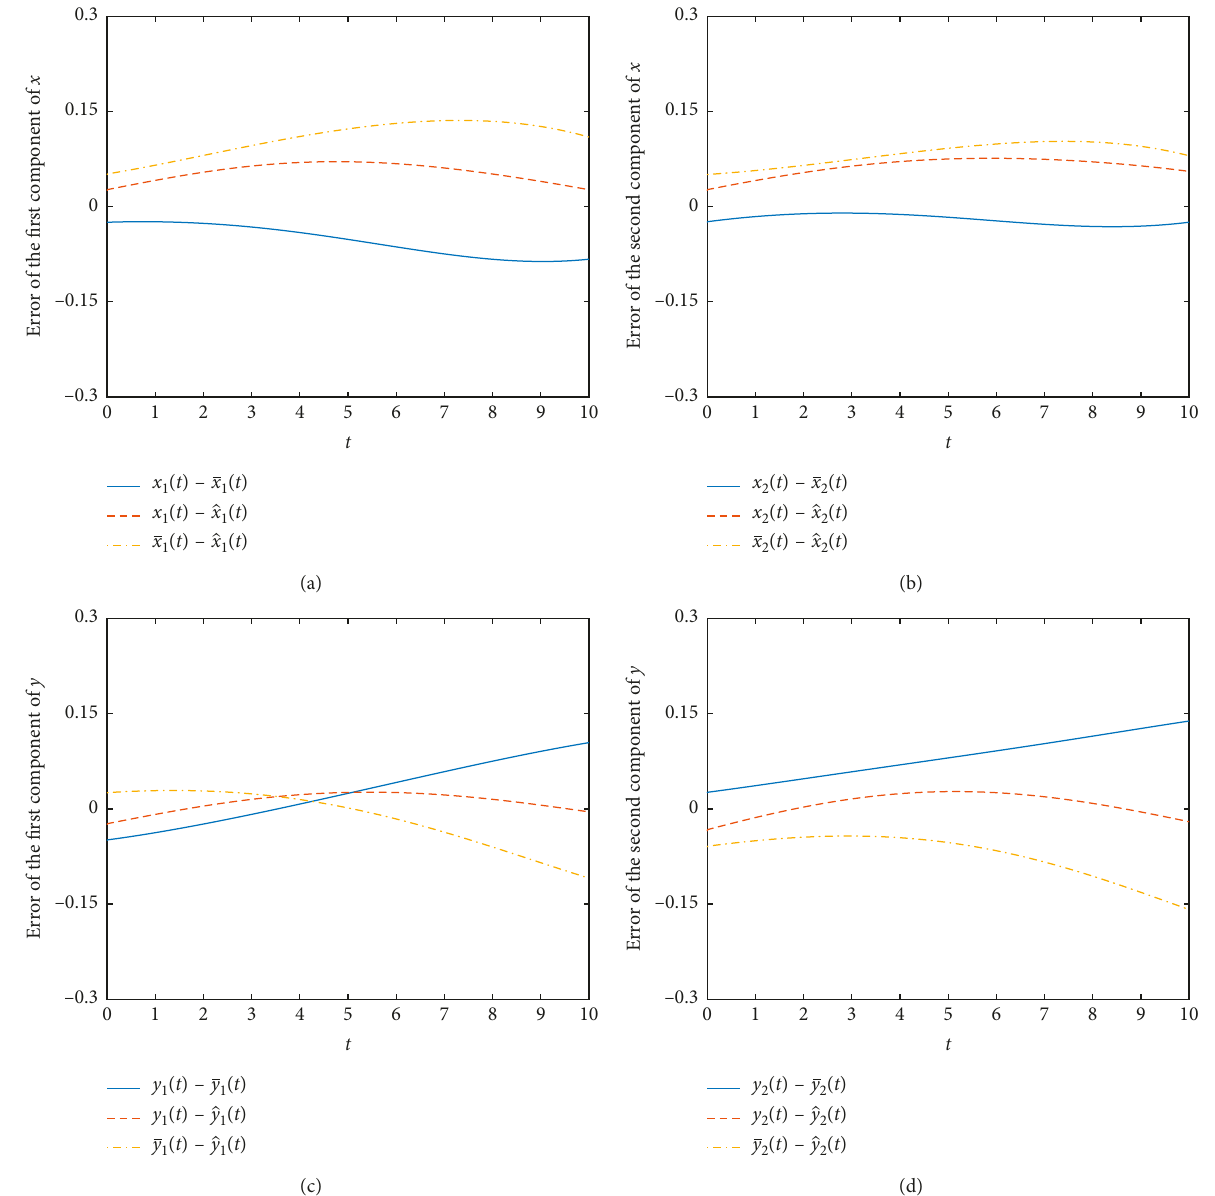
Figure 6: State trajectories of error systems for the system in Example